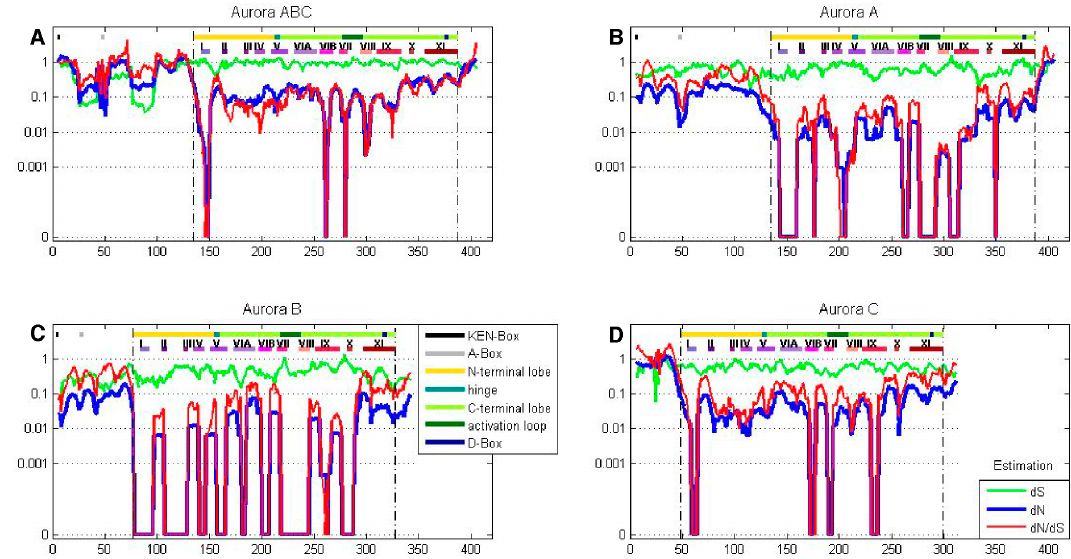
Figure 4. A sliding window analysis of the AK gene family exhibits the twelve kinase subdomains. A ten amino acid sliding window was employed to determine dN (blue), dS (green) and dN / dS (red) value for ( A ) the entire AK gene, ( B ) AKA , ( C ) AKB , and ( D ) AKC . Values were plotted at the center of each window. Dashed lines demarcate the kinase domain. The bars highlight motifs, including the N-terminal lobe; the hinge; the C-terminal lobe; the activation loop; the KEN-, A-, and D-boxes; and the twelve kinase subdomains (I–XI).